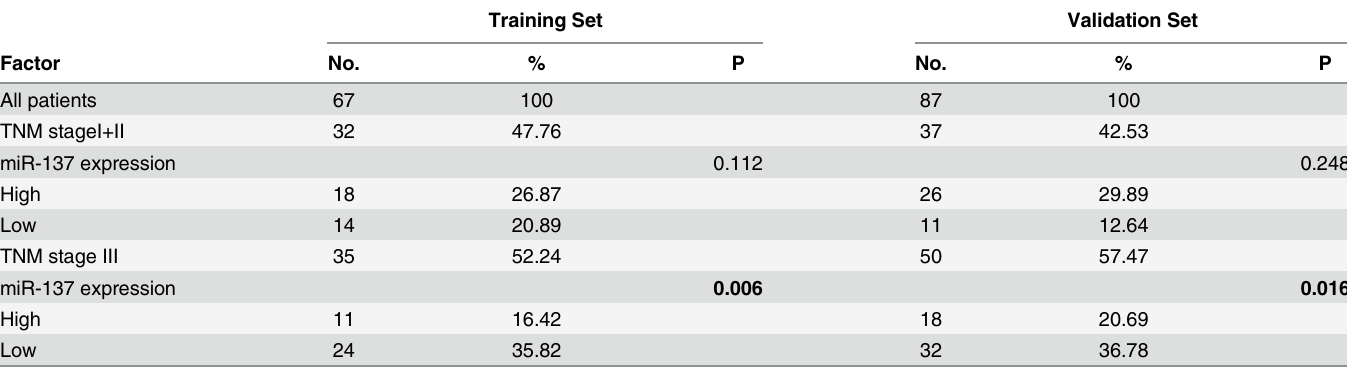
Table 4. Log-rank test on overall survival for TNM stage split by miR-137 expression. Training Set Validation